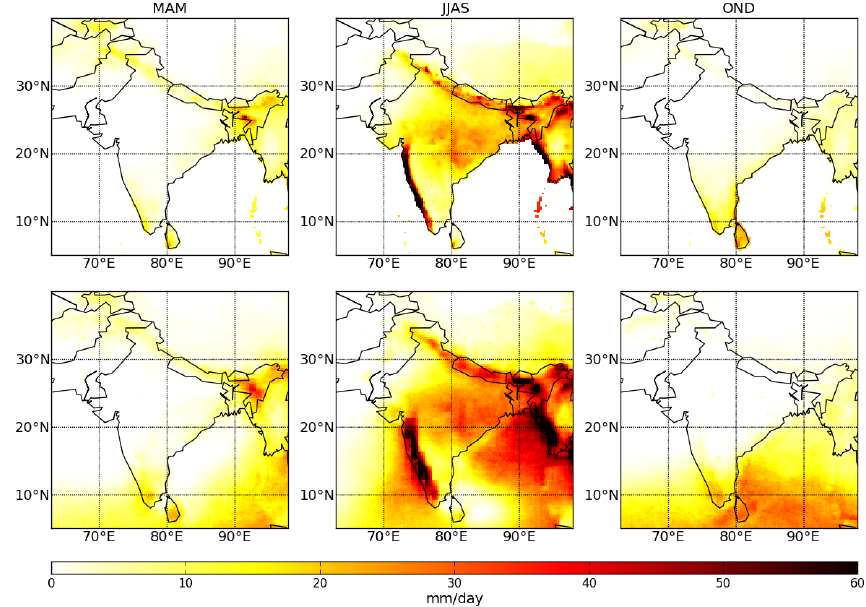
Figure 2. 90th percentile of daily rainfall amounts for the pre-monsoon (MAM), monsoon (JJAS), and post-monsoon (OND) periods for the APHRODITE (top) and TRMM (bottom) data sets using the same color scale. Table 2. Network measures. N – total number of nodes. D j – degree of a node j . B v – betweenness of a node v . L ij – geographical link length between nodes i and j . ALL i – average geographical link length of a node i . MLL i – maximal geographical link length of a node i . σ v (i,j) – the number of shortest paths between nodes i and j passing through node v . σ(i, j) – total number of shortest paths between i